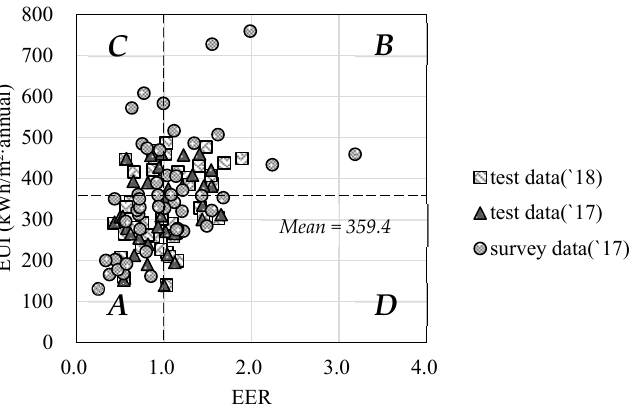
Figure 3. EUI and EER comparison of survey and pilot assessment hospitals. The A–D area was classified based on the hospital’s average EUI and EER 1 point.